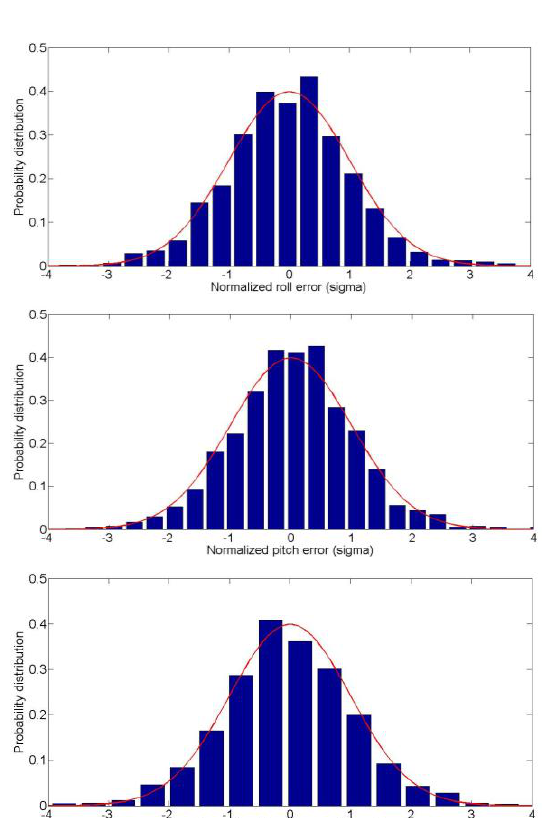
Figure 10: Distribution of the boresight errors (roll/pitch/heading)